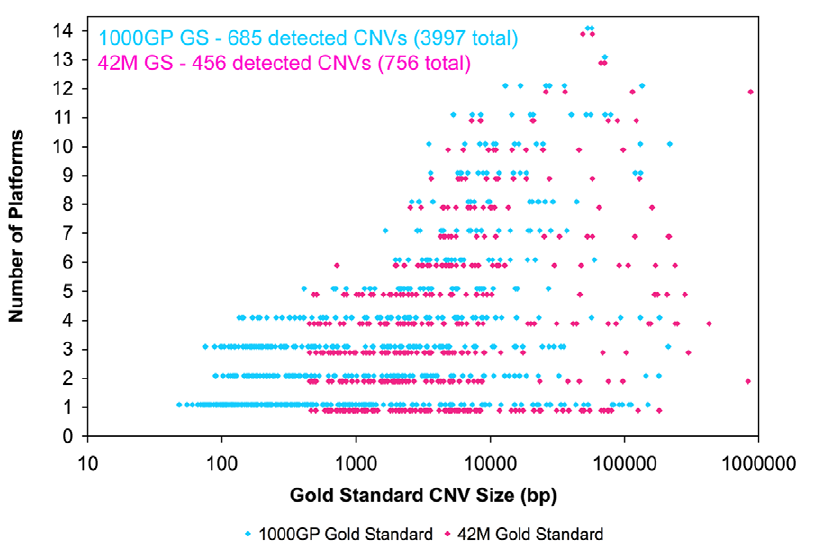
Figure 6. Number of array platforms detecting each Gold Standard CNV by size. Each data point represents the number of platforms that detect a certain Gold Standard CNV by at least one technical replicate using our overlap criteria versus the size of the Gold Standard CNV. Only detectable Gold Standard CNVs are shown. Blue points correspond to 1000GP GS CNVs and pink points correspond to 42 M GS CNVs.